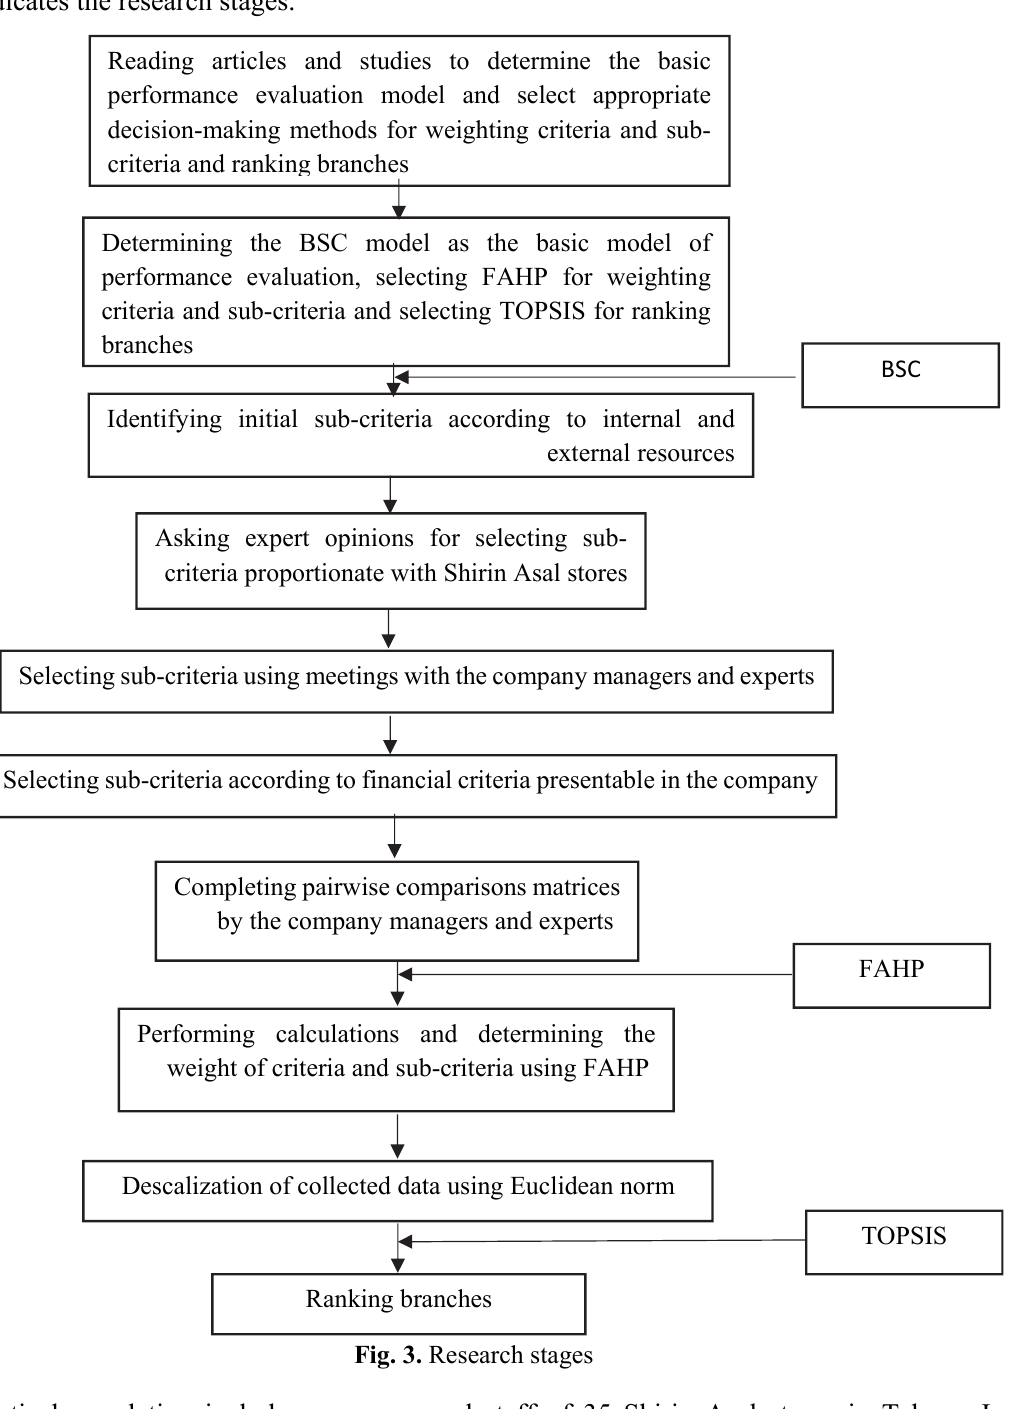
Fig. 3 indicates the research